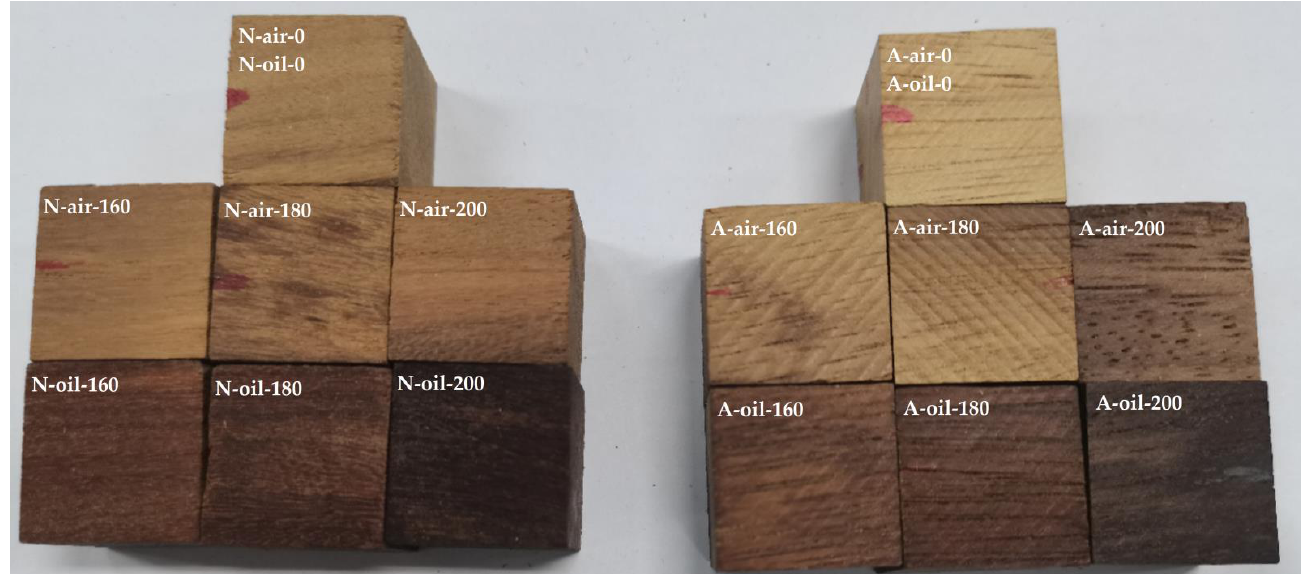
Figure 2. Wood samples before and after heat treatment.